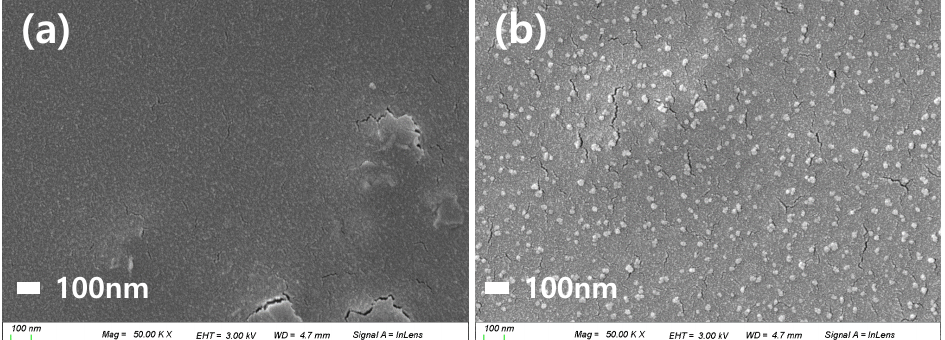
Figure 9. SEM analysis of ( a ) ref sample and ( b ) Ce sample.